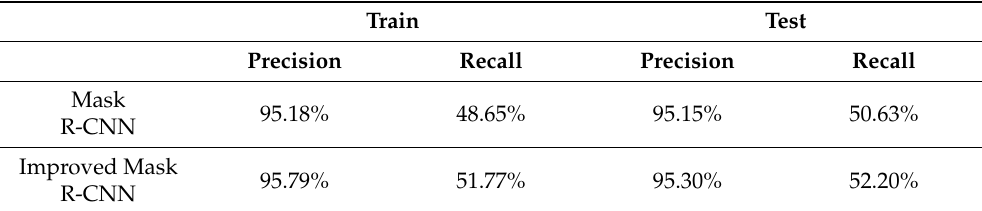
Table 5. Results of precision and recall on the training and testing datasets.